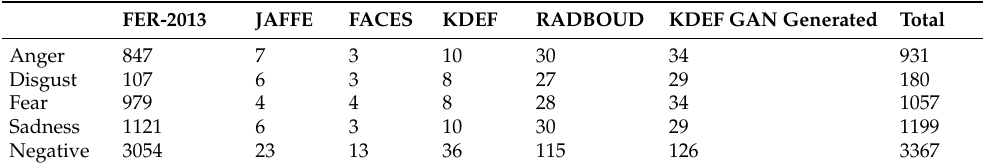
Table 8. Testing Data for Negative Class (Model B).